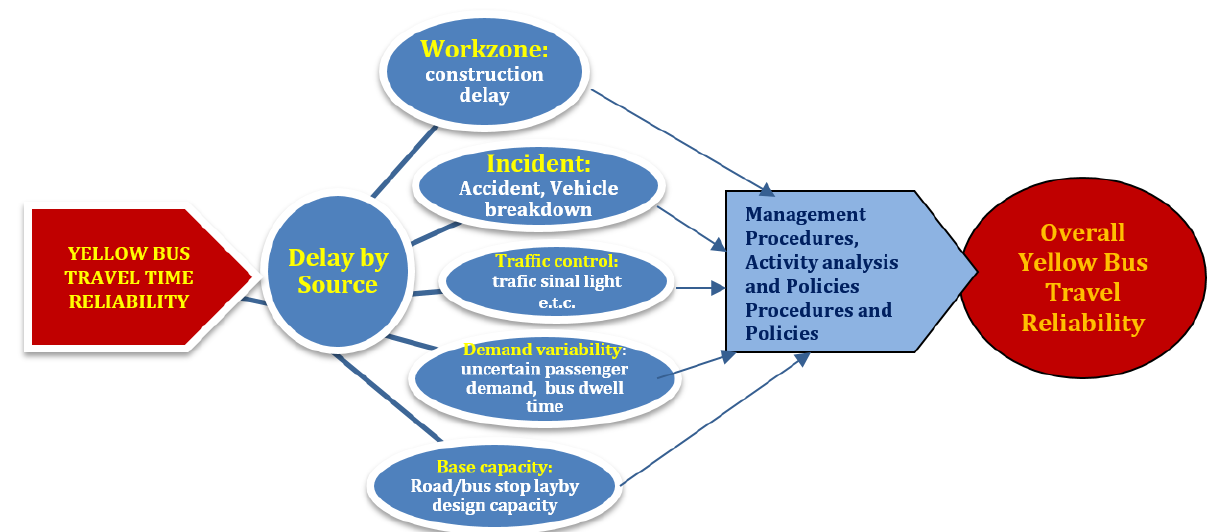
Figure 2: Research conceptual